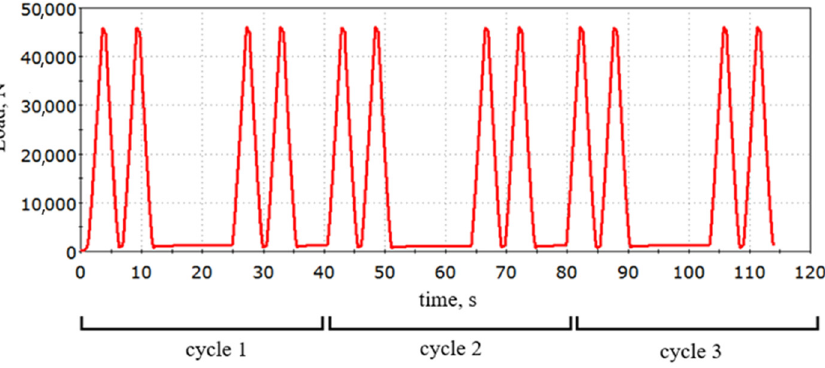
Figure 3. Cyclorama for testing rail fragments with a maximum load of 45 kN.